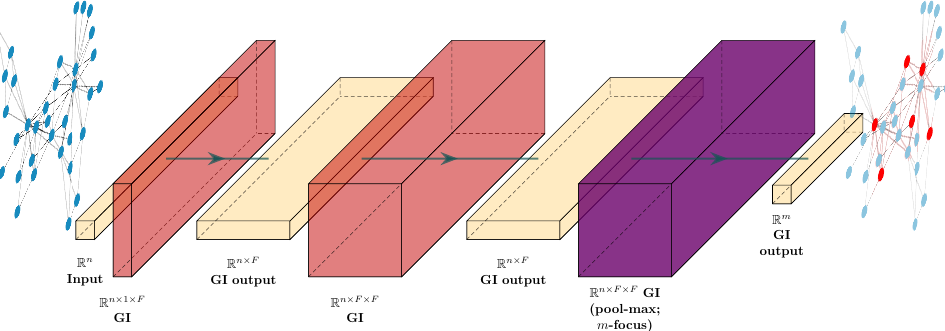
Figure 5. Example of a GINN archetype with depth H = 2 and max-pooling operation for the output layer. The output matrices Y of the NN layers are in orange, the weight tensors W of the hidden GI layers are in red (see Definition 3), and the weight tensor W of the output GI layer with max-pooling and masking operations (see Section 2.3) are in